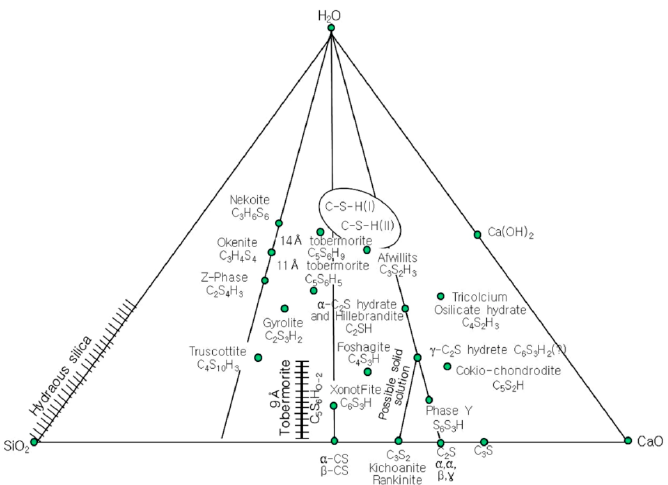
Figure 7. Compounds in C-S-H system.